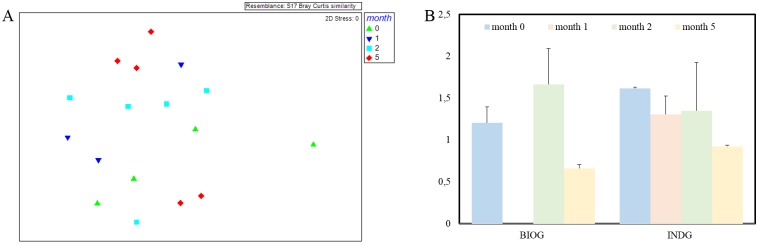
ARISA results.A) Non-metric multidimensional scaling (nMDS) ordination based on Bray–Curtis similarities from ARISA fingerprints of marine biofilm communities on the polyethylene pieces during the experiment (phase II), B) Shannon–Wiener diversity index among the different PE biofilm communities.